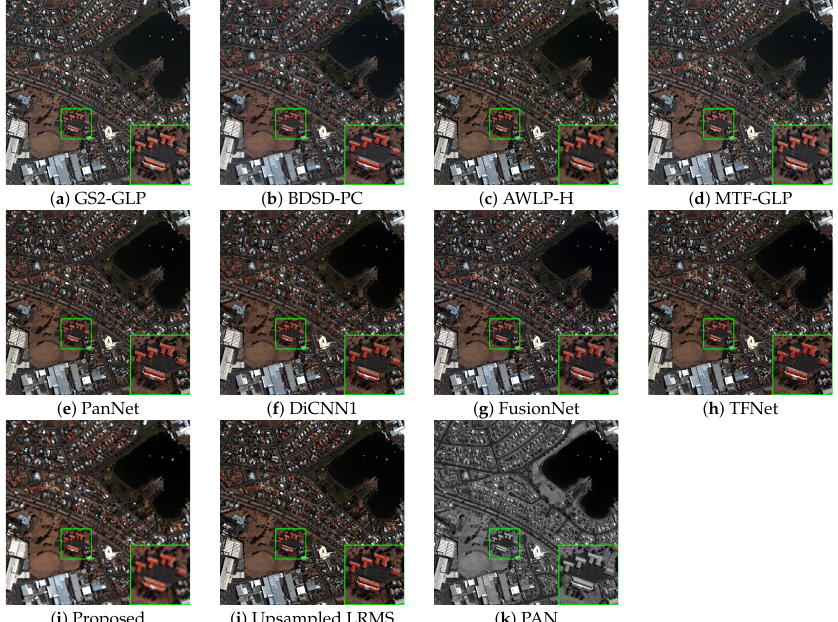
Figure 8. Fusion results of a group of full-resolution samples on the Ikonos dataset.